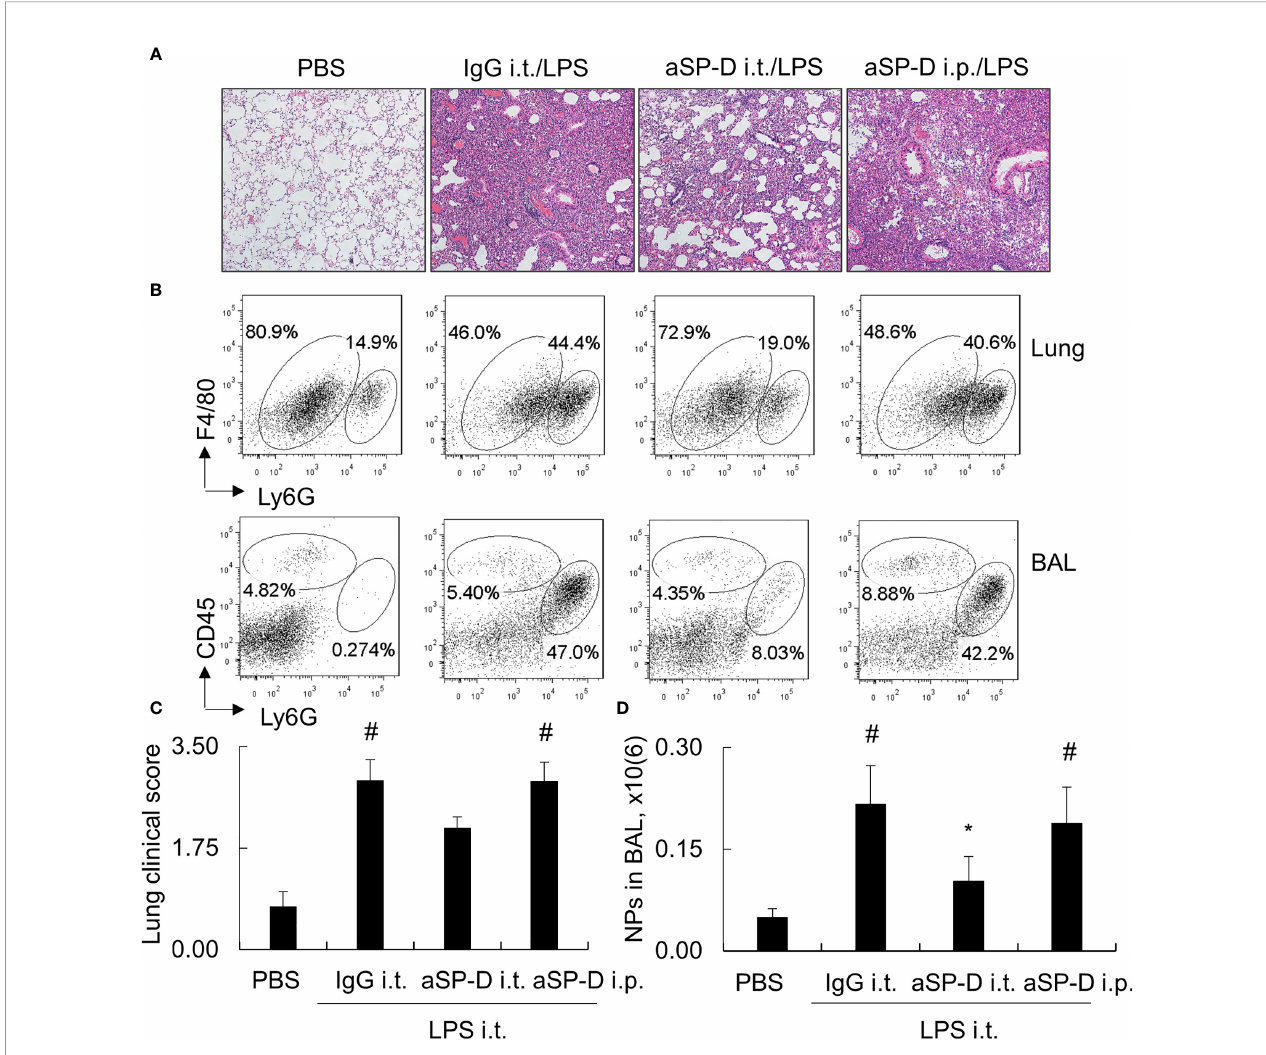
FIGURE 7 | Intratracheal administration of anti-surfactant protein D (aSP-D) antibody attenuated the severity of acute lung injury (ALI) and in fl ammation in the lungs of mice. Here, 10 − 12-week-old C57BL/6 male mice were intratracheal (i.t.) or intraperitoneal (i.p.) co-treated with 0.4 mg aSP-D/kg and 5 mg/kg lipopolysaccharide (LPS) for 2 days (aSP-D i.t./LPS group and aSP-D i.p./LPS group). Mice treated with phosphate buffered saline (PBS) and immunoglobulin G (IgG)/LPS were controls. (A) Lung histology by H&E staining. Representative photograph with magni fi cation ×100. (B) Flow cytometry analysis for neutrophils (NPs) and macrophages (MPs) in lung tissues and bronchoalveolar lavage (BAL). NPs were identi fi ed as Ly6G+ cells; MPs were identi fi ed as CD45+Ly6G(-) cells. (C) Quantitative analysis of lung pathological score. (D) Absolute number of NPs in BAL. *p < 0.05 vs . IgG/LPS group; # p < 0.05 vs . PBS